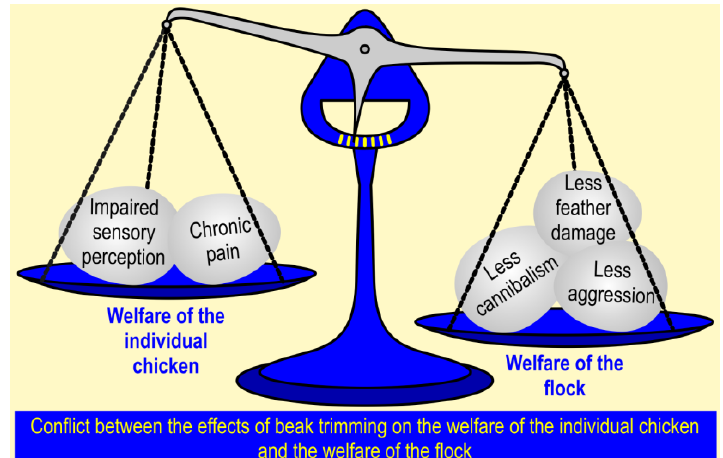
Figure 1. Beak trimming in chickens. This procedure reduces the consequences, but not the incidence, of severe feather pecking. Although it causes discomfort in the individual chicken, the flock may profit from this intervention because the consequences of feather pecking are generally less severe [33,37]. The general question thus is whether the harm inflicted on the individual outweighs the benefits for the individual and/or the group [2]. This figure shows, as a hypothetical example, the evaluation concluding that the effects of beak trimming are favorable for the welfare of the flock. Depending on a different weighing of the arguments, the conclusion may be that prophylactic beak trimming is unacceptable. For example, in breeds with a very low incidence of feather pecking, trying to reduce the suffering of some of the birds by mutilating all of them seems completely unacceptable from a purely animal welfare perspective, whereas in breeds with a very high incidence of feather pecking, beak trimming might be considered more acceptable. Alternative solutions to beak trimming must be taken into account before even considering the use of mutilating procedures.